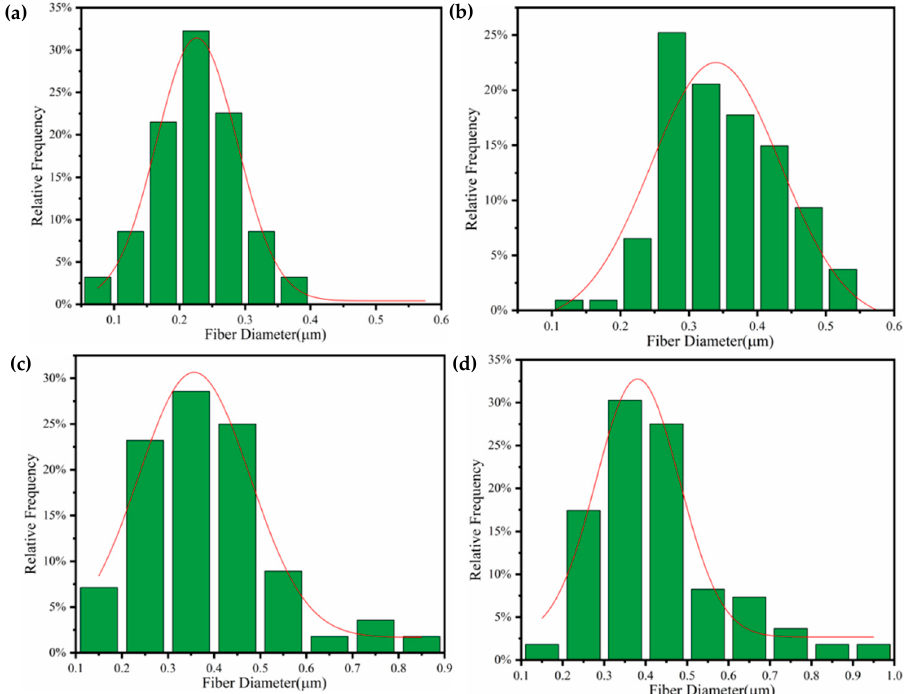
Figure 3. Fiber diameter distribution of PVDF/CA EFMs: ( a ) pure PVDF; ( b ) PVDF/CA-1; ( c ) PVDF/CA-2; ( d )